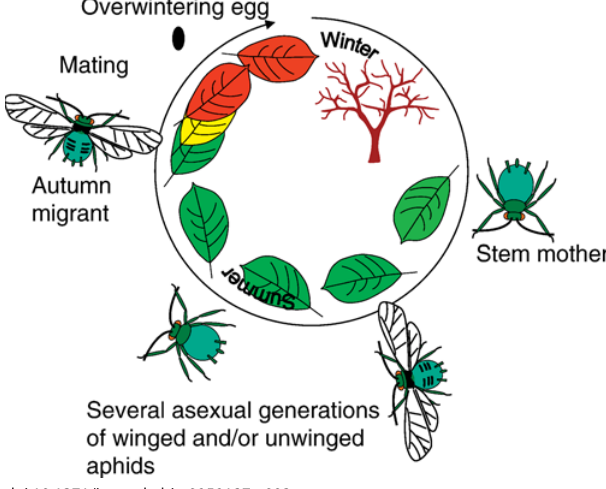
Figure 2. Typical Aphid Annual Life Cycle In spring the stem mother (fundatrix) hatches from a fertilized egg and asexually produces female offspring. During spring and summer, there is little variation between target colors, since most leaves will be green. In autumn, winged aphids migrate towards their winter hosts, and might choose between leaves based on variation in color cues. Note that many aphid species diverge considerably from this stereotypic life